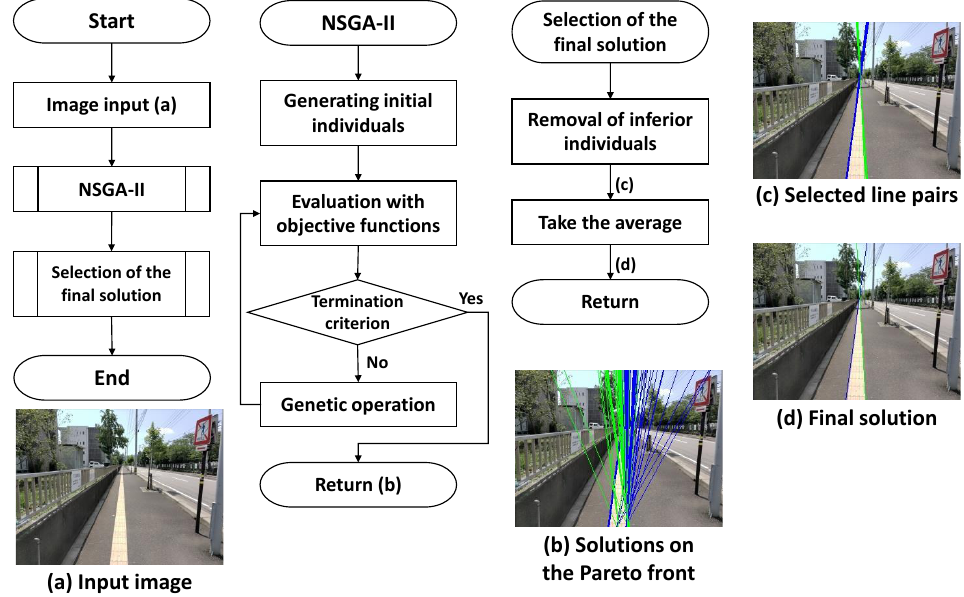
Figure 2. Overview of our proposed